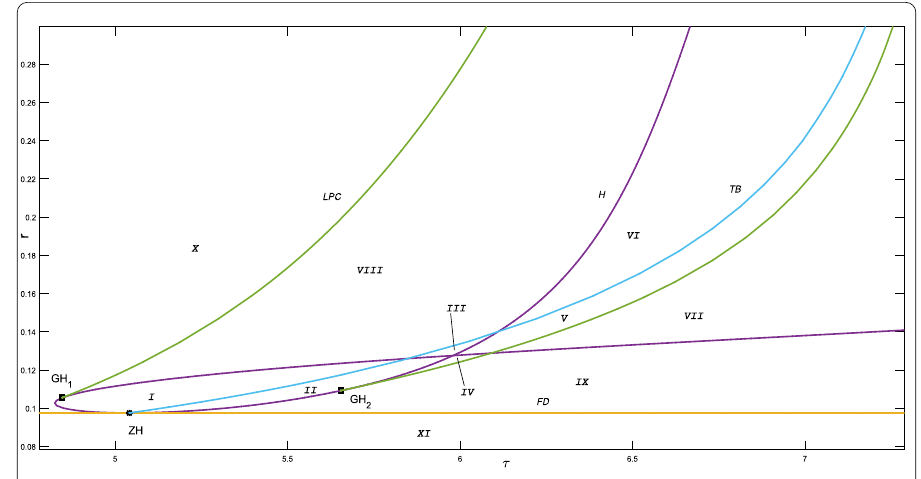
Figure 1 Bifurcation diagram of system (1) in τ – r plane. Bifurcation curves: H (violet) Hopf; FD (orange) Fold; LPC (green) Limit point of cycles; TB (cyan) Torus. Special points: GH 1 and GH 2 (Bautin);